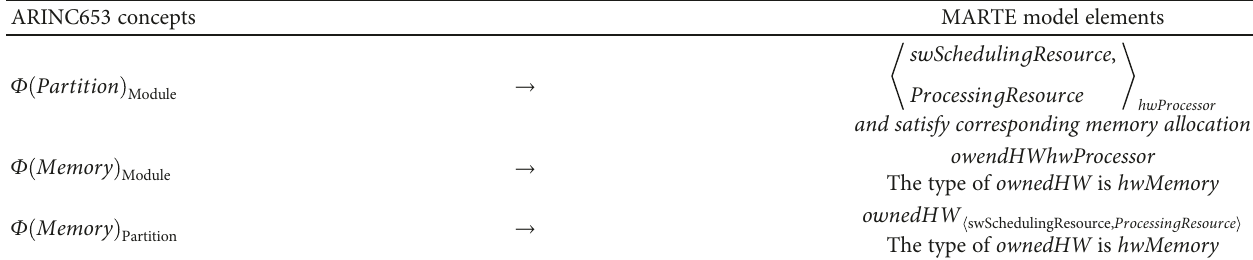
Figure 3: Module con fi guration transformation from ARINC653 to MARTE. Table 3: Partition transformation